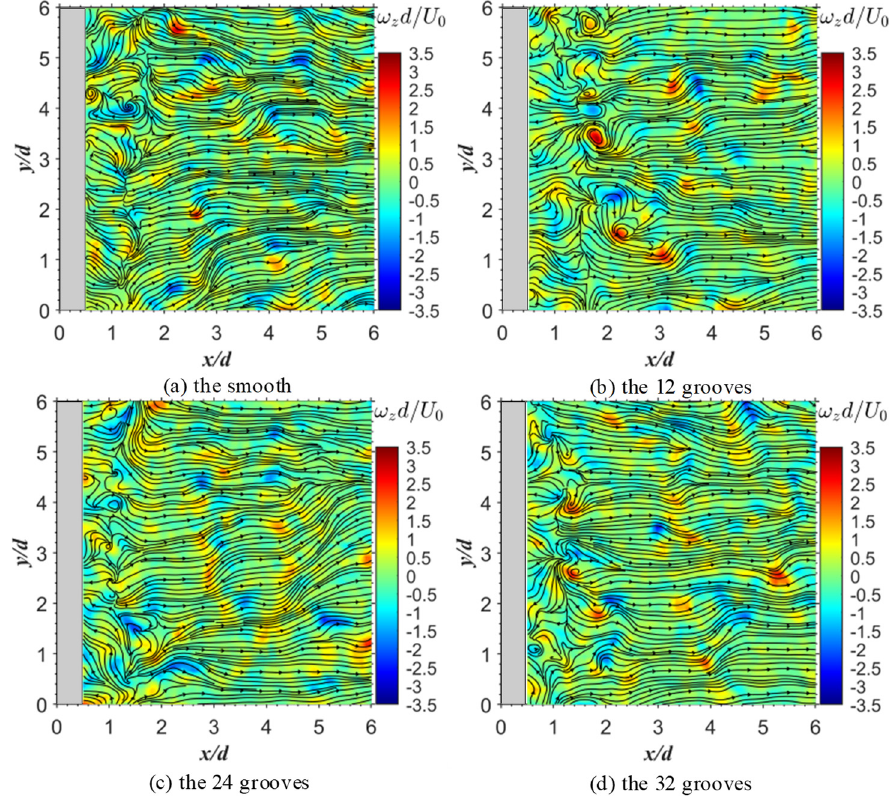
Figure 12. Instantaneous streamlines and normalized vorticity contours in the (x, z)-plane.